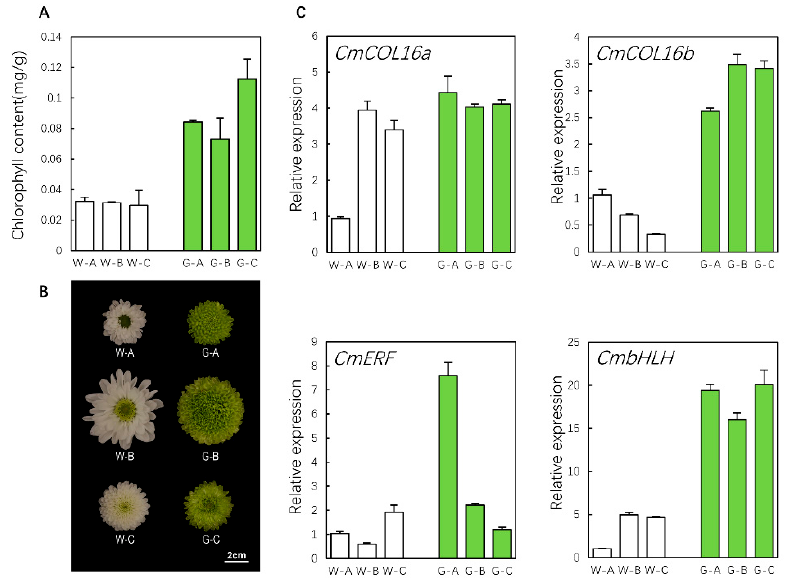
Figure 10. qRT-PCR analysis of hub genes in petals of green and white ray florets of chrysanthe- mum. ( A – C ) Chlorophyll content ( A ), color ( B ), and expression of hub genes in the six mum. (A–C) Chlorophyll content (A), color (B), and expression of hub genes in the six commercial